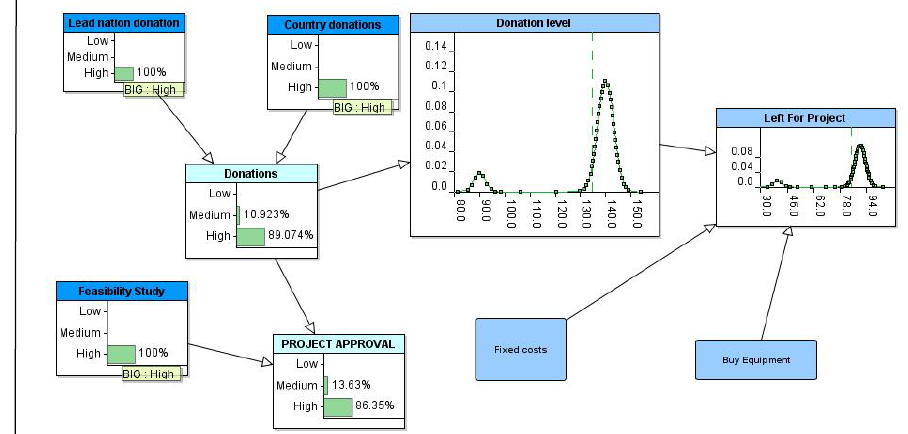
Figure 5 – Risk Map model with the initial probabilities for scenario 2 Рис . 5 – Карта рисков с инициальной вероятностью по сценарию 2 Слика 5 – Мапа ризика са иницијалним вероватноћама за сценарио